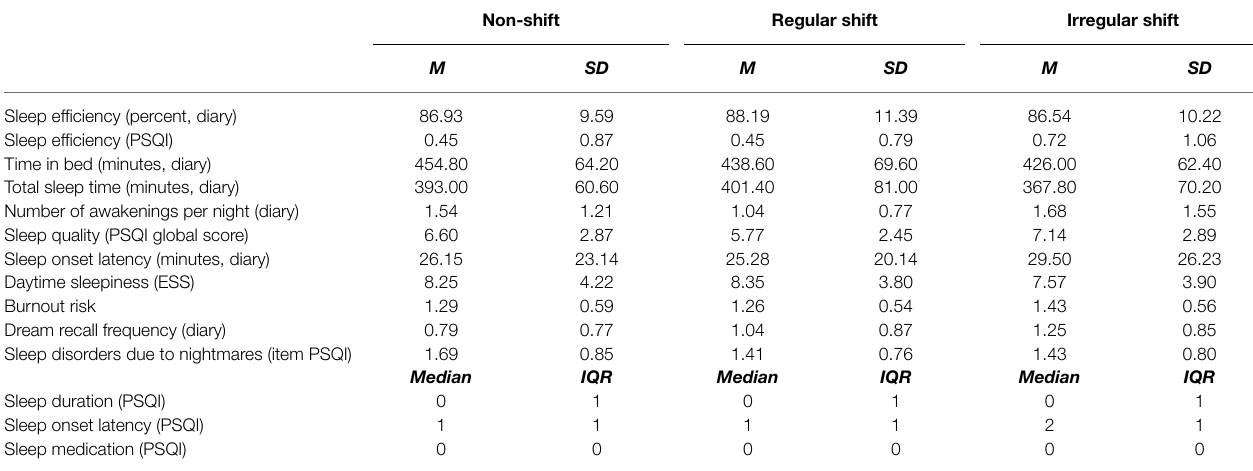
TABLE 3 | Means and standard deviations, respectively, medians and interquartile ranges of insomnia-related symptoms for each group.